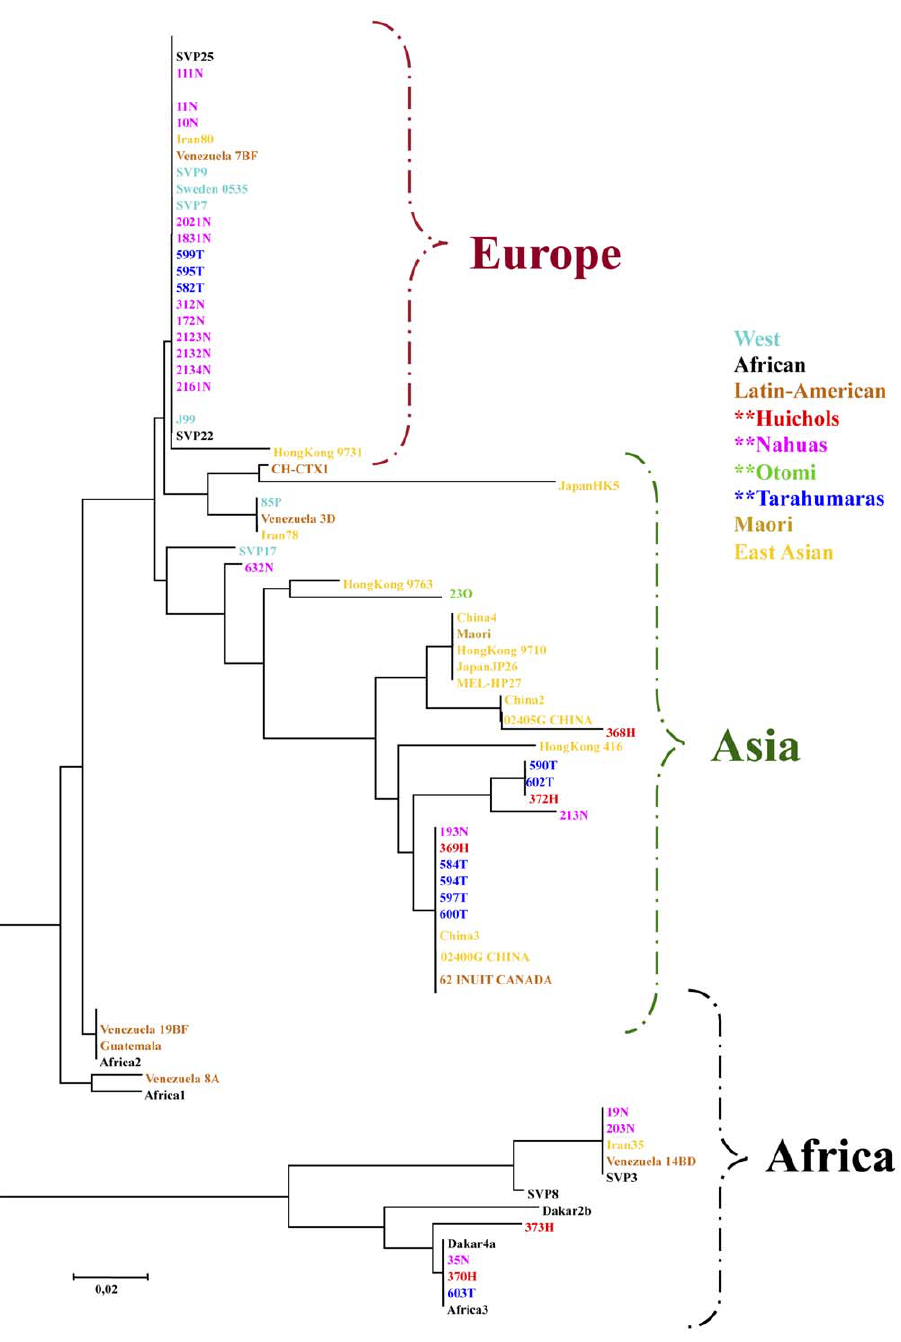
Figure 4. Phylogenetic analysis of sequences of hspA of H.pylori strains from Mexican native groups. The trees were constructed by the Neighbor-joining method based on Kimura’s two-parameter model distance matrices. Phylogenetic analyses of hspA shows that whereas many of the Nahua strains clustered in the Europe group, many of the Tarahumara isolates clutered in the Asia group together with Huichol strains. Some isolates also grouped in the Africa group.